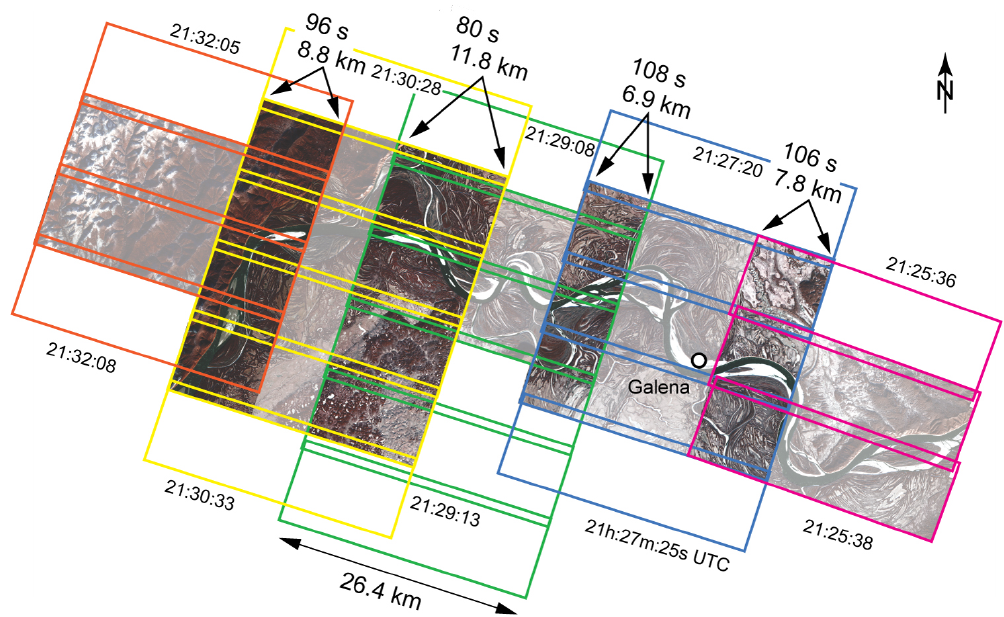
Figure 3. Typical PlanetScope acquisition pattern on a cloud-free day during freeze-up (28 October 2018) over the Yukon River at Galena, Alaska (64.75 ◦ N, 157 ◦ W). Each colour indicates one satellite swath with individual scenes. Non-dimmed parts of the image indicate scene sections where two images with a time lag between them exist and river ice floes can be tracked. The time lag and width of the overlaps are given along with the time (UTC) of the